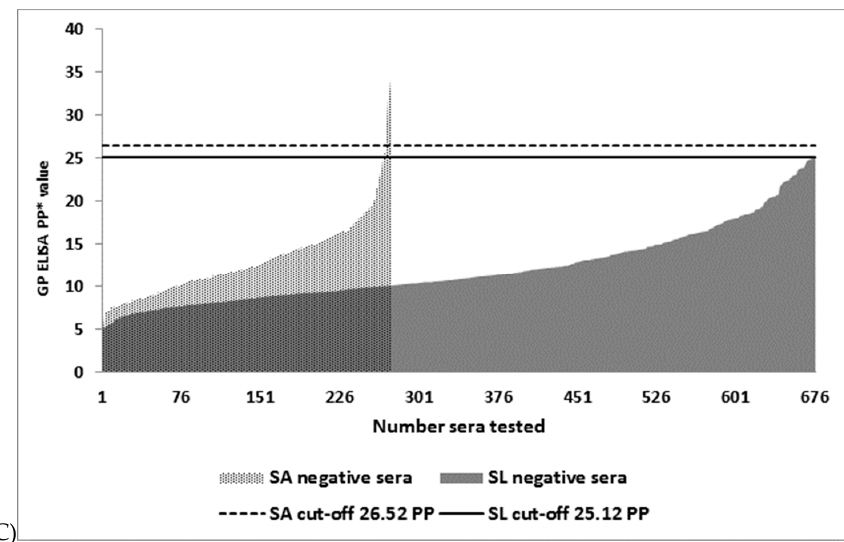
Figure 1. Distribution of percentage positivity (PP) values in South African (SA) and Sierra Leonean (SL) Ebola virus (EBOV) immunoglobulin G (IgG) negative human sera and selection of cut-off values for ( A ) the whole antigen (WAg), ( B ) nucleocapsid protein (NP) and ( C ) glycoprotein (GP) based ELISAs. Cut-off value for each assay was calculated as mean plus three standard deviations of ELISA PP (percentage positivity of internal positive control serum) values recorded by each test in 273 SA and 676 SL EVD negative sera, respectively.